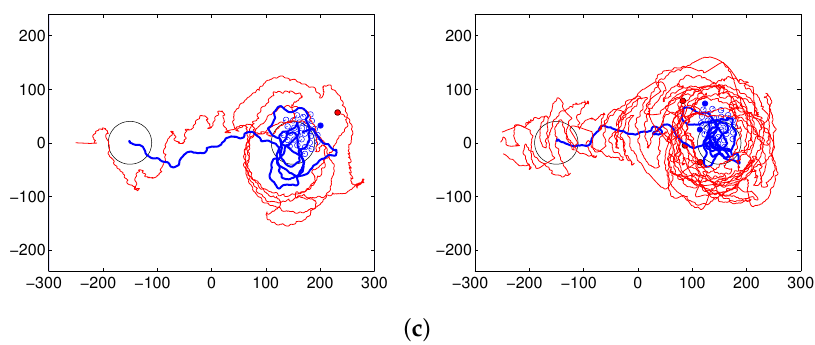
Figure 4. Results of ( a ) herding, ( b ) patrolling and ( c ) covering behaviors with (left panels) one and (right panels) three steering robots.